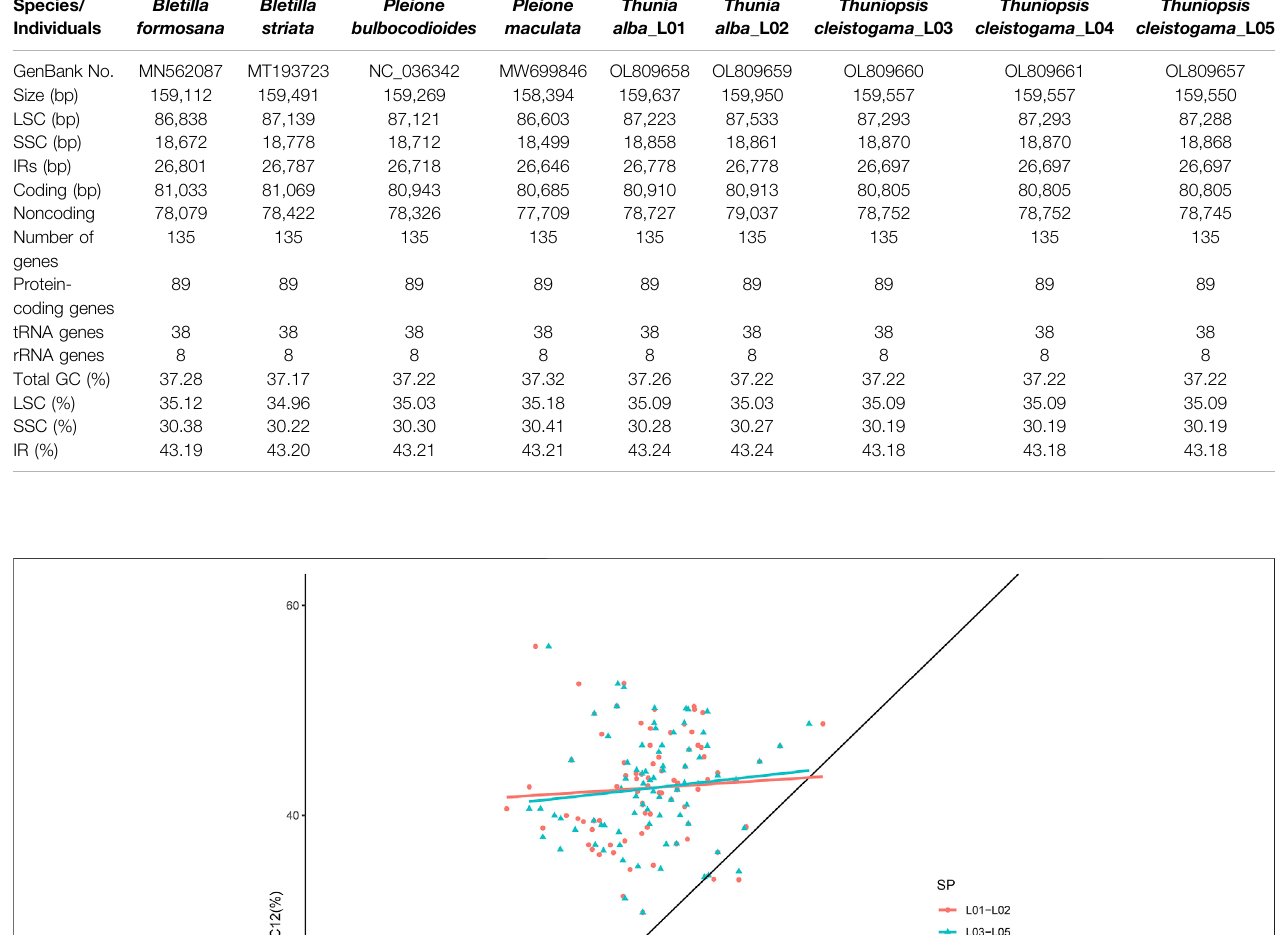
In the neutrality plot of all the genes generated, the slope of the regression line was close to zero, and most plotted points did not lie on or along the diagonal line. These data gave evidence that the codon preference was dominated by natural selection (Sueoka, 1988). Compared to Thuniopsis cleistogama , the slope of the